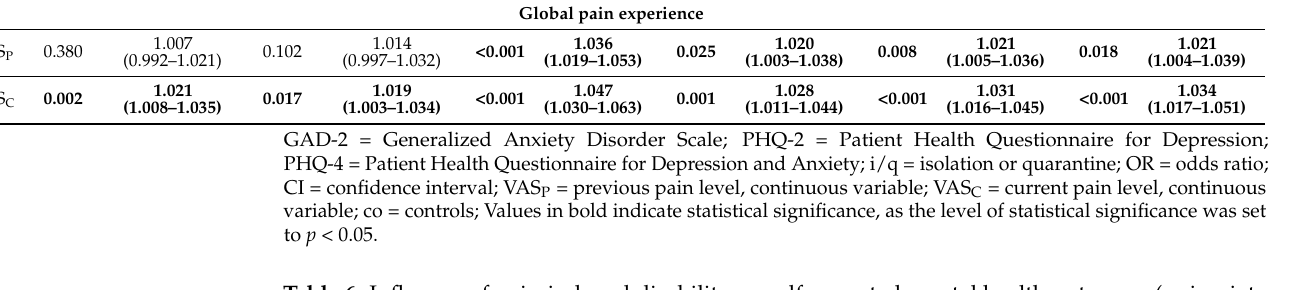
Table 6. Influence of pain-induced disability on self–reported mental health outcomes (univariate logistic regression